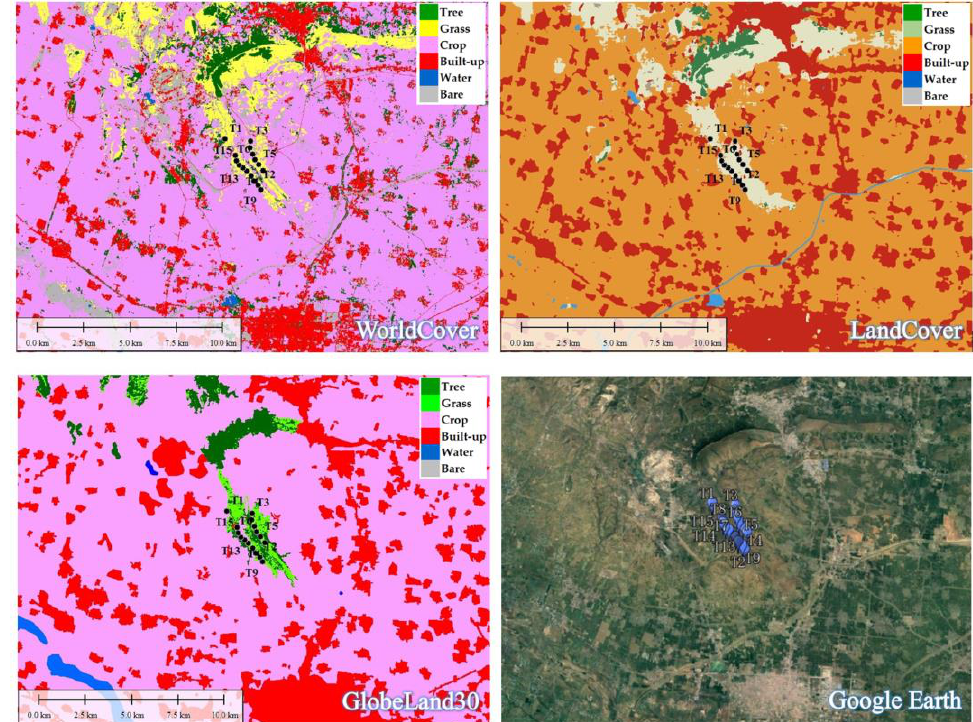
Figure 1. Comparison of remote Angle of View on different Surface coverage data of Wind Farm.